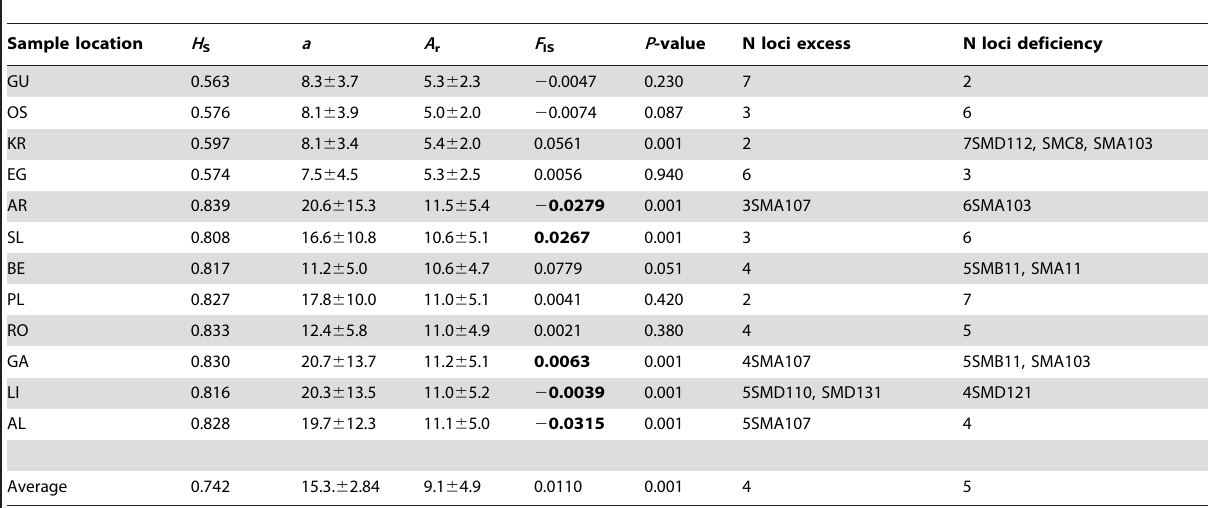
Table 3. Summary statistics for genetic variability within sample sites.